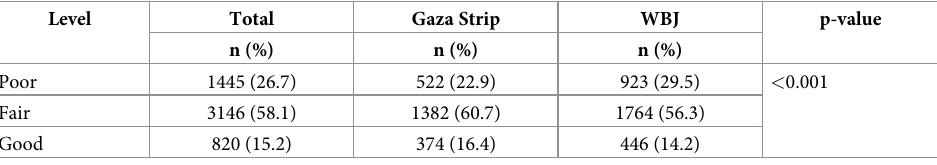
Table 3. Awareness level of ovarian cancer risk and protective factors among study